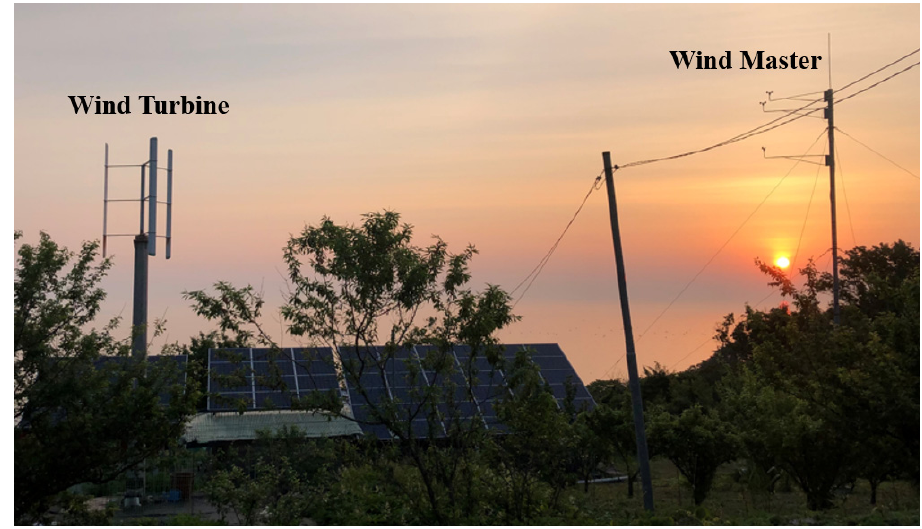
Figure 5. Wind turbine at experimental site The wind turbine power is proportional to the cubic power of the wind speed. Wind speed with time was measured using a cup-anemometer installed on the met-mast, as shown in Figure 5. The wind speed data were measured and stored for one full year, 2016. Figure 6 shows the power curve of the wind turbine.